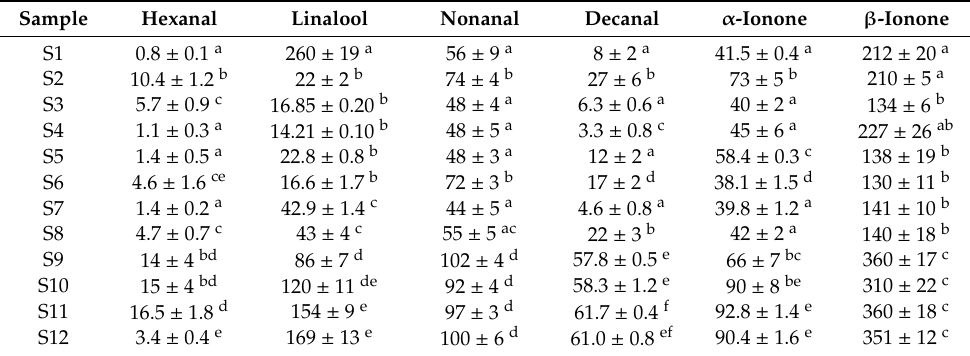
Table 3. Content of volatile compounds quantified by GC-MS expressed as mg per 100 g of raspberry fruit (mean ± SD, n =